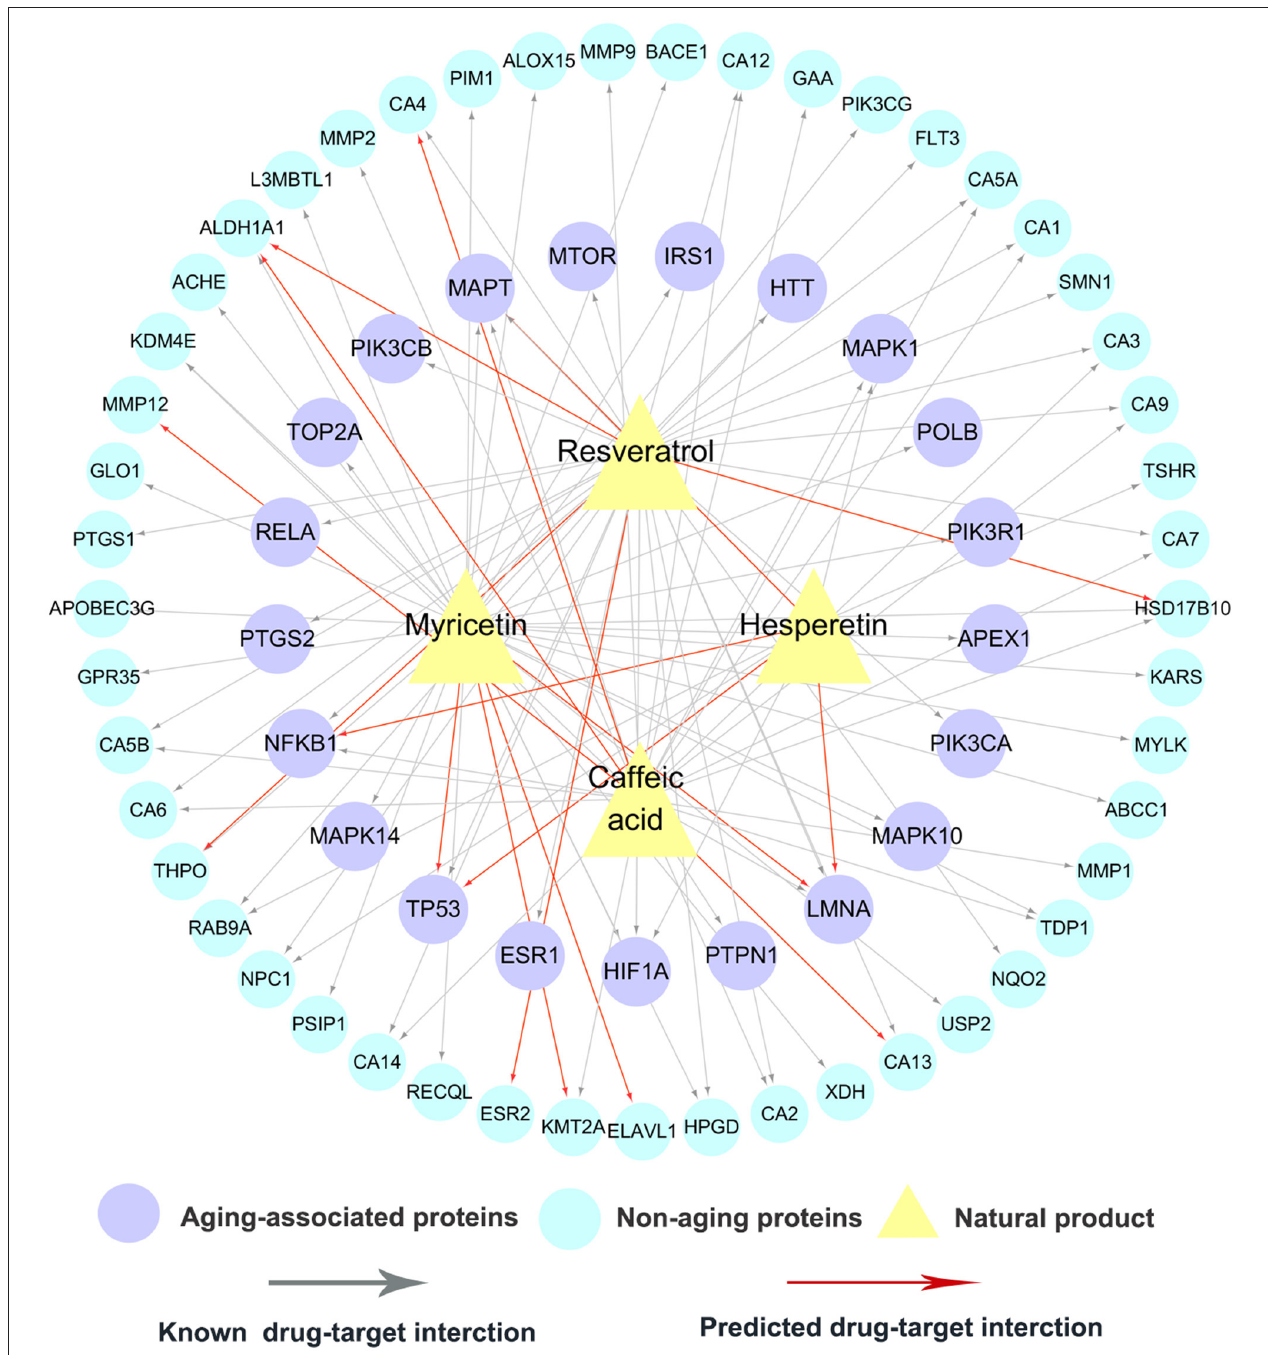
FIGURE 5 | A bipartite drug-target network for 4 typical natural products. This network includes 90 experimentally validated and 16 computationally predicted drug-target interactions connecting 4 natural products (caffeic acid, hesperetin, myricetin and resveratrol) and 70 targets (21 aging-associated proteins and 49 non-aging